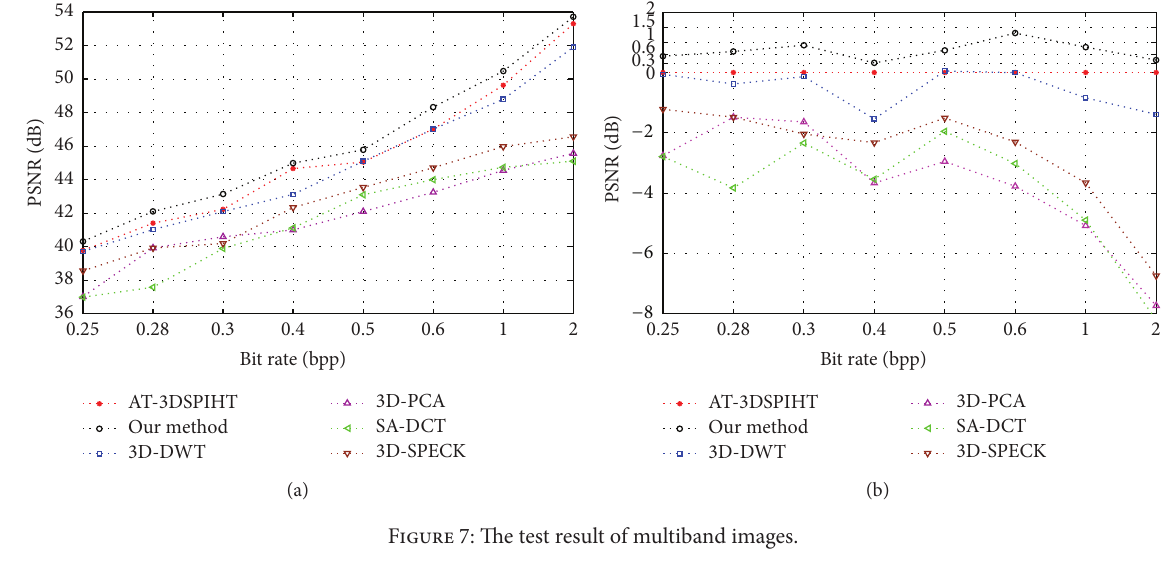
Figure 7: The test result of multiband